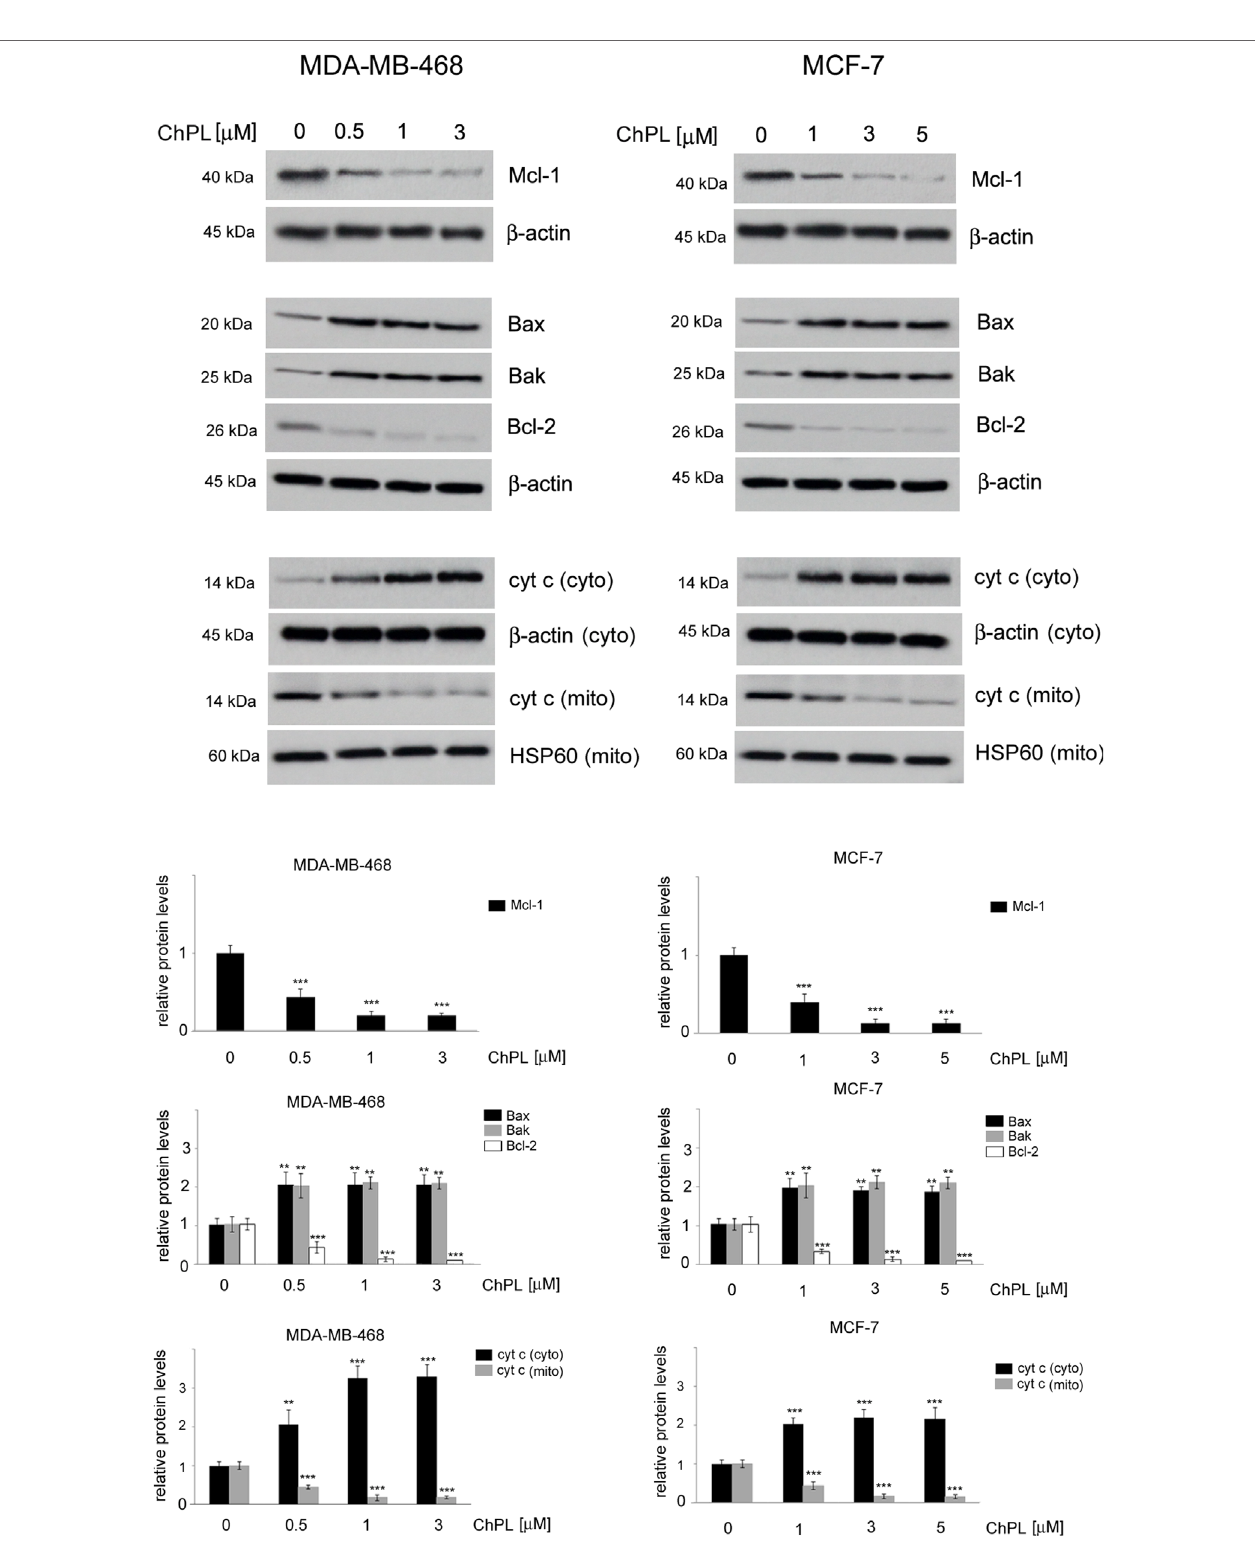
FIGURE 3 | Effects of 3-chloroplumbagin on the expression levels of Bcl-2 family proteins and cytochrome c in breast cancer cells. MDA-MB-468 and MCF-7 cells were treated with the indicated concentrations of ChPL for 24 h, and the levels of Mcl-1, Bax, Bak, Bcl-2 and cytochrome c were assessed by Western blot analysis. Densitometric analysis represents protein levels normalized to β -actin levels or HSP60 levels. Data were analyzed by one-way ANOVA with Tukey’s post hoc tests [ p < 0.01 (**), p < 0.001 (***), n =